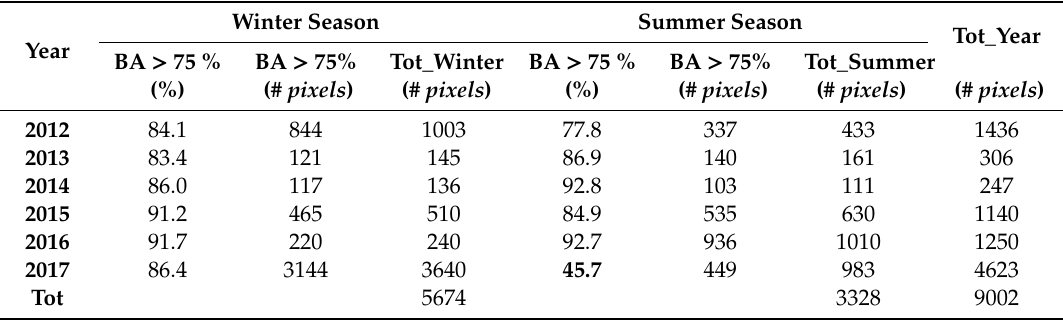
Table 4. Model validation evaluated by computing the percentage of the predicted burning area above the 75th percentile falling inside the testing burned areas for each single year (BA > 75%). The number of pixels above and below this value for each season are also